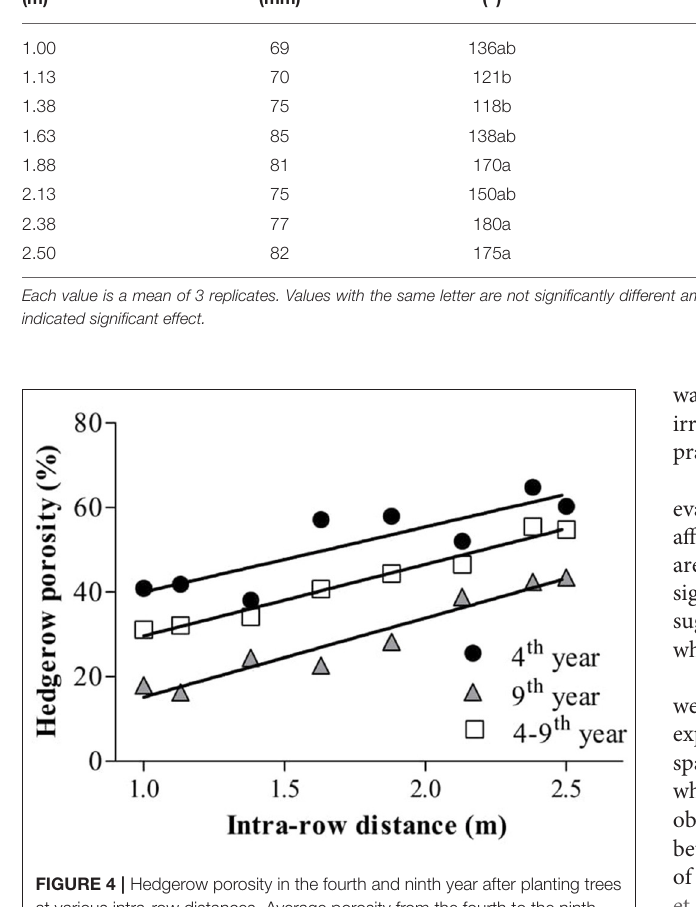
TABLE 2 | Structure of trunk and branches in the 8th year of trees planted at various intra-row spacing. Intra-row spacing